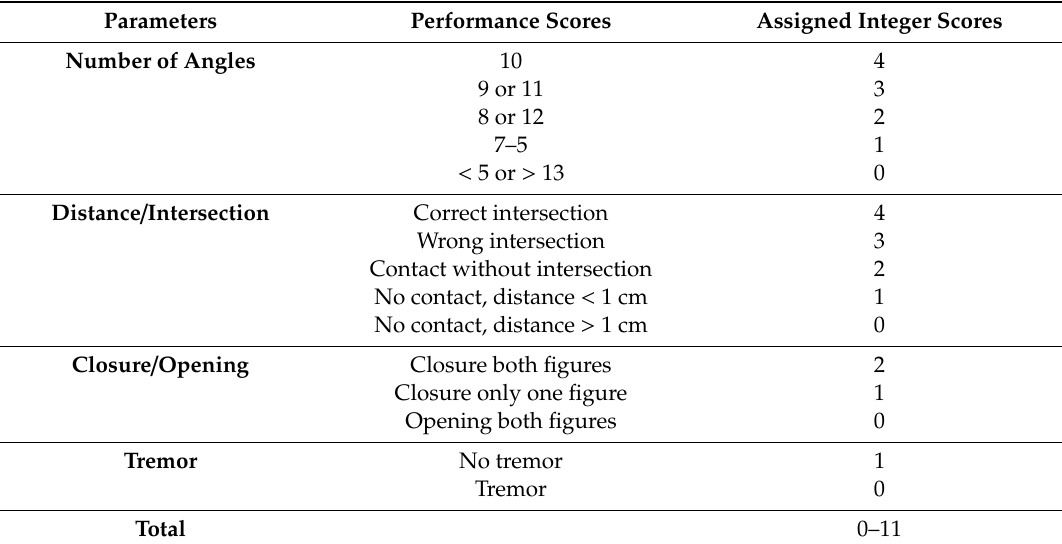
Table 2. A detailed list of the parameters for the scoring